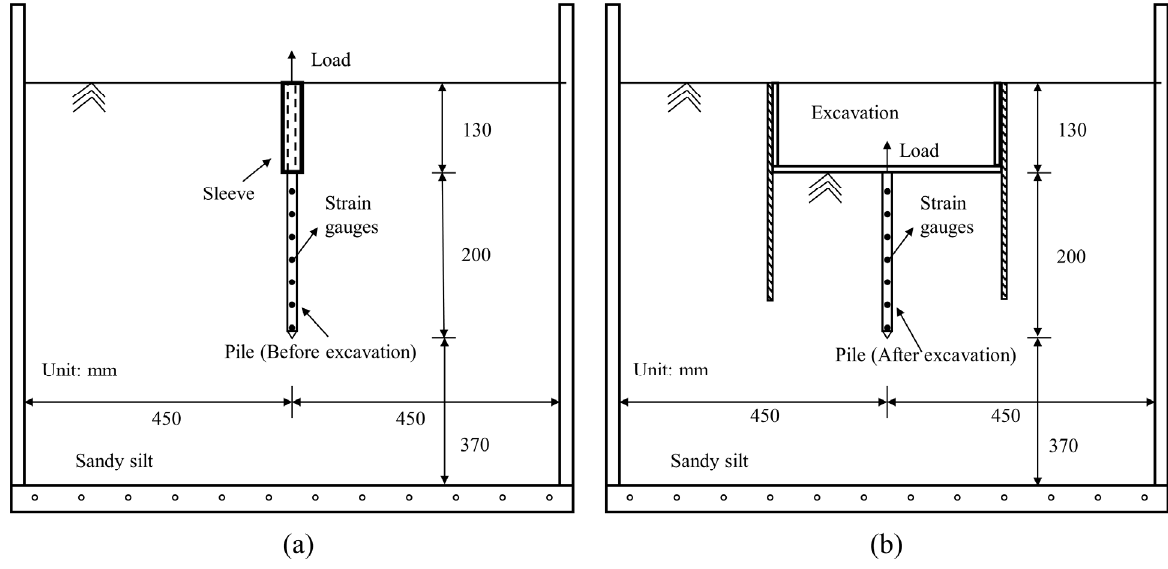
Figure 8. A sketch of the centrifuge model tests: ( a ) before excavation, ( b ) after excavation. Table 2. Physical and mechanical properties of sandy silt.